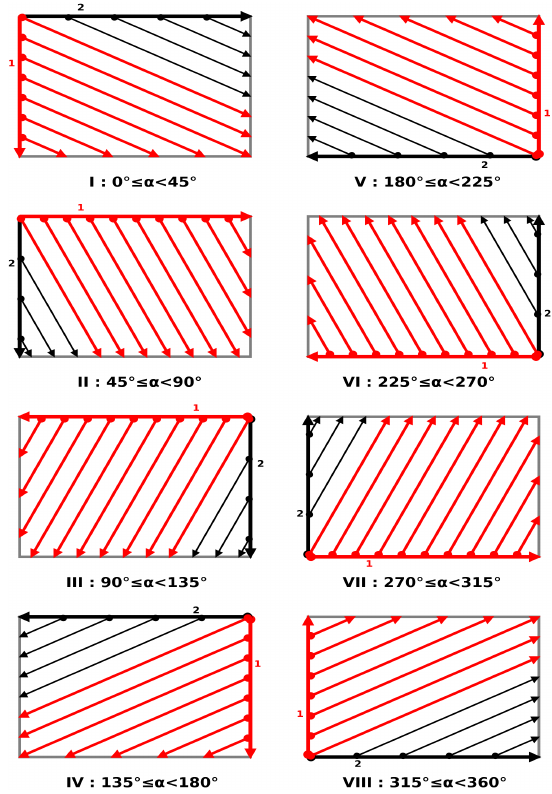
Figure 1. Primary (red) and secondary (black) sweeps over the image to be interpolated for paths with an arbitrary slope α